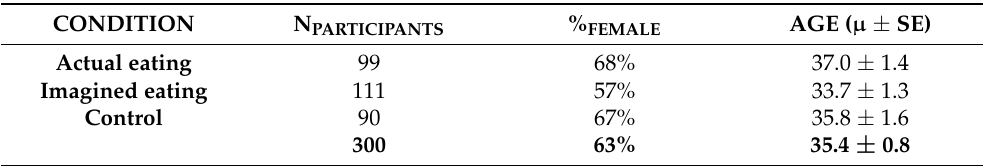
Table 1. Demography of included participants. The aim was to recruit 100 participants per condition for a total of 300